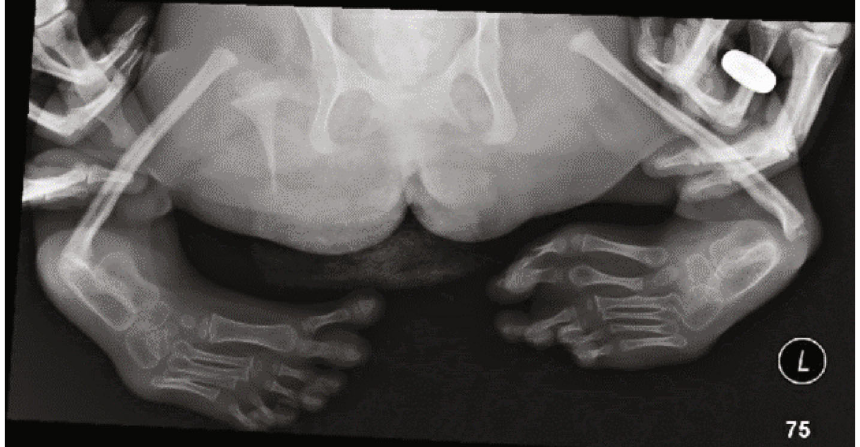
Figure 2: X-ray showing severe deformity of bilateral feet with severe hindfoot varus bilaterally. There are 6 phalanges in the right foot, 2 of them articulating with the fi rst toe metatarsal. There are 6 metatarsals and 6 phalanges in the left foot.